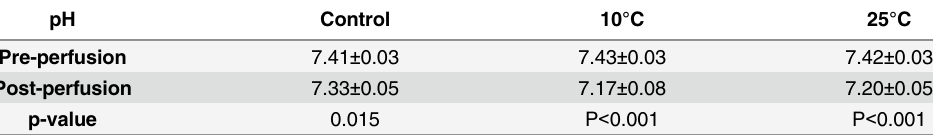
Table 4. Acid-base balance in the perfusate at the end of the perfusion period in the control group and the gradual rewarming groups. * P < 0.05 vs control group. Values are mean ± standard deviation